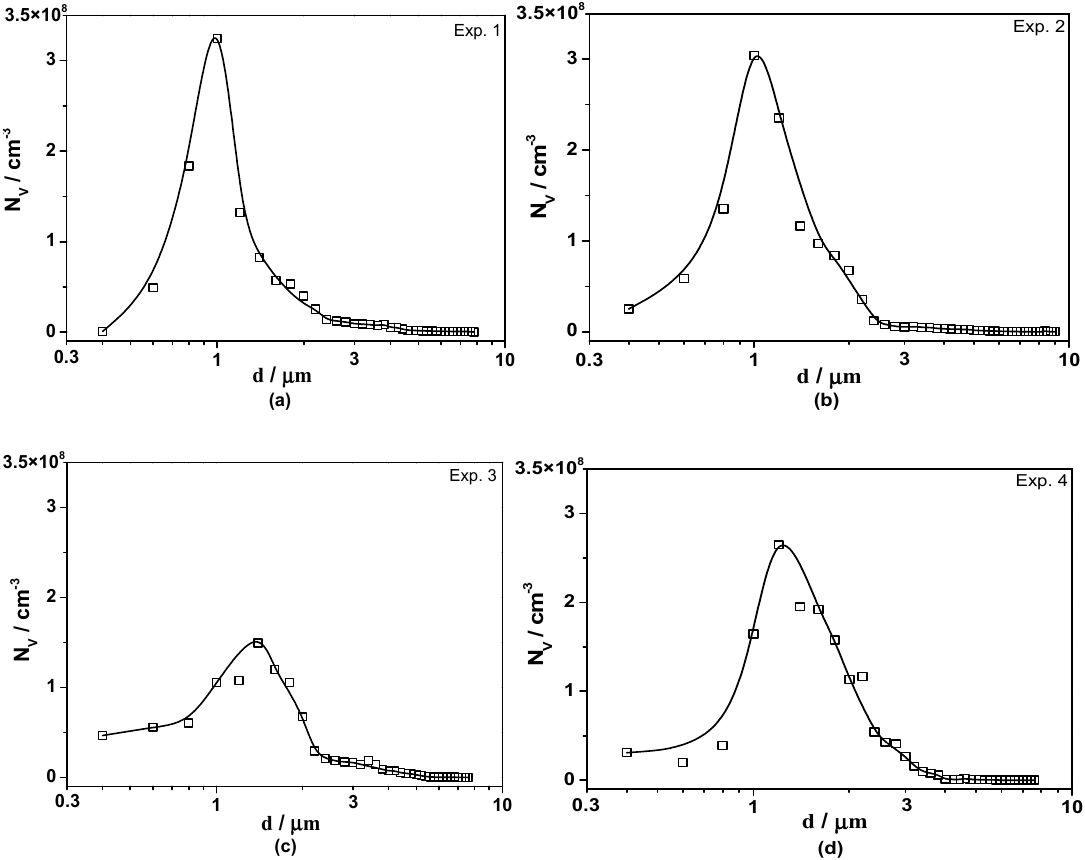
Figure 5. Three-dimensional inclusion size distribution with single-phased morphology. ( a ) Experiment 1; ( b ) Experiment 2; ( c ) Experiment 3; ( d ) Experiment 4.